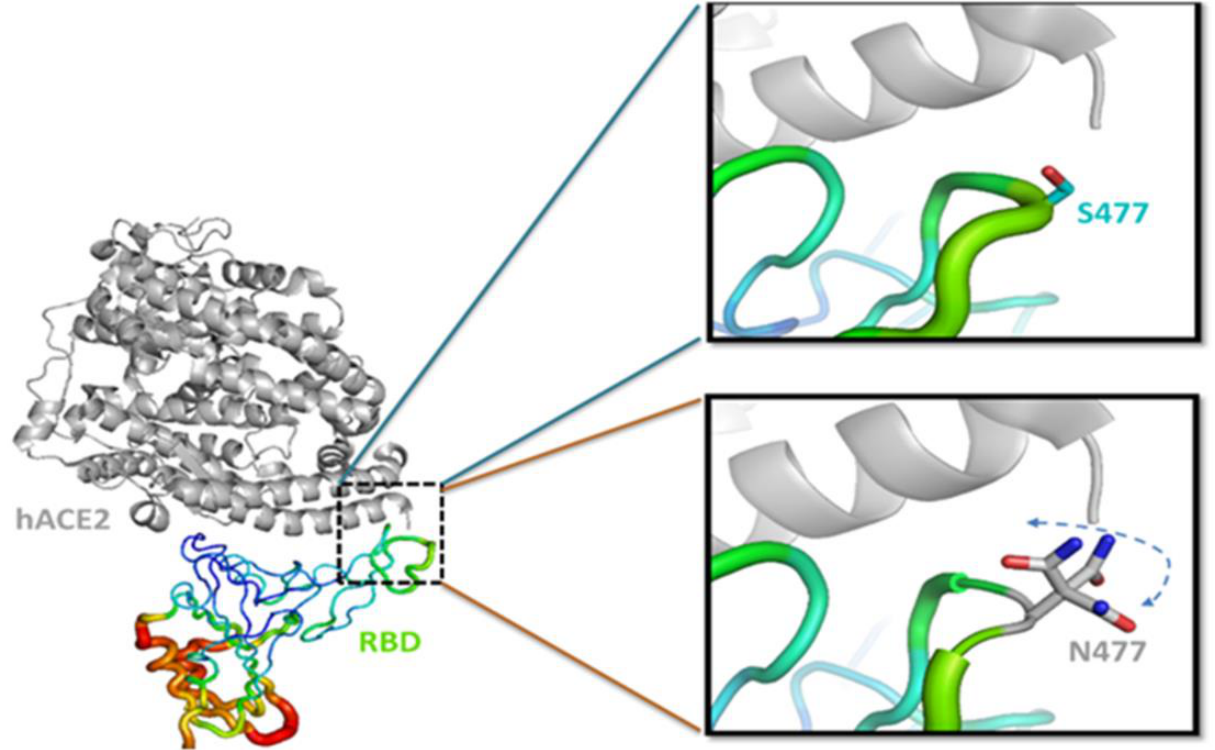
Figure 4. The RBD and hACE2 interactions were taken from the PDB structure (PDB: 6M0J). The hACE2 is shown in gray and RBD as a β factor diagram (shown in rainbow). The S477 (wild type) is magnified in the upper right box. The N477 (mutated) is magnified in the lower right box. The side chains of N477 are in different rotamers, increasing its propensity of binding with hACE2 in comparison with the wild type.